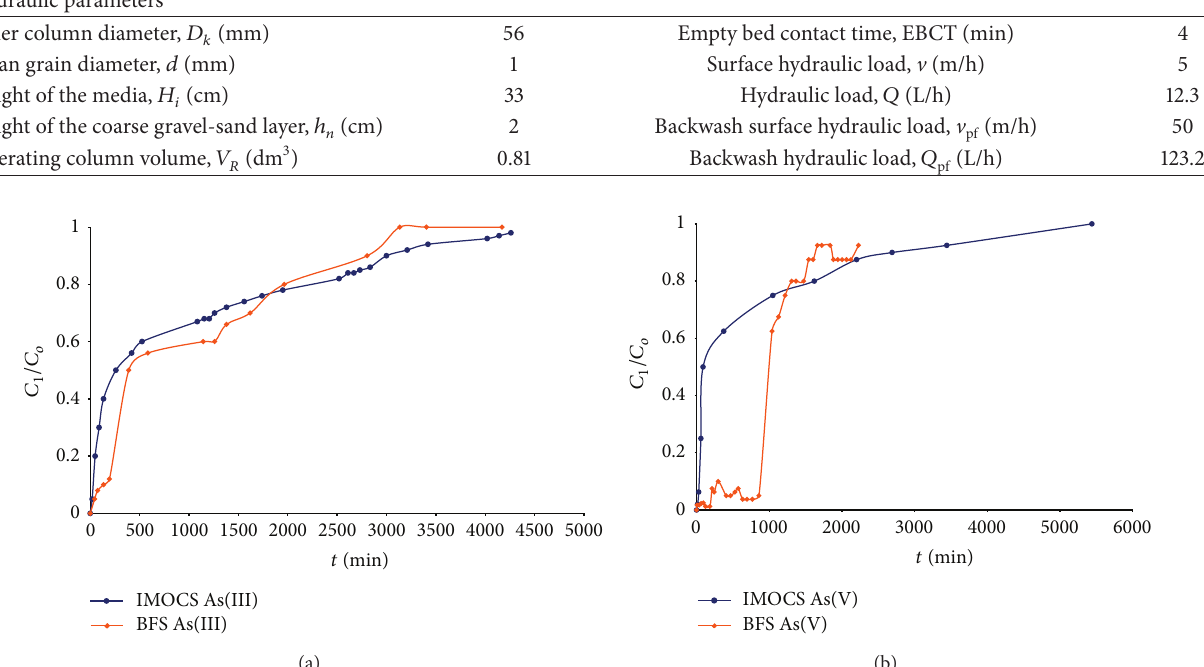
Figure 4: Breakthrough curves of As(III) and As(V) removal by IMOCS and